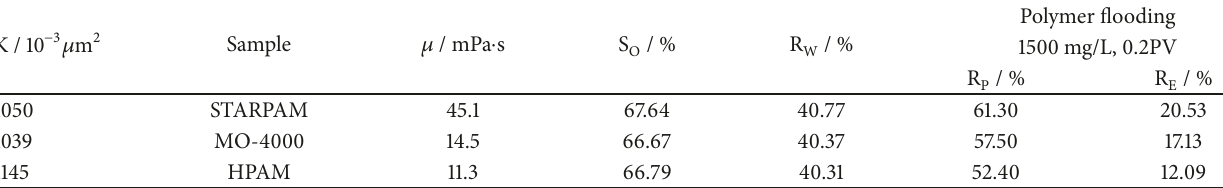
Table 9: Comparison of oil displacement